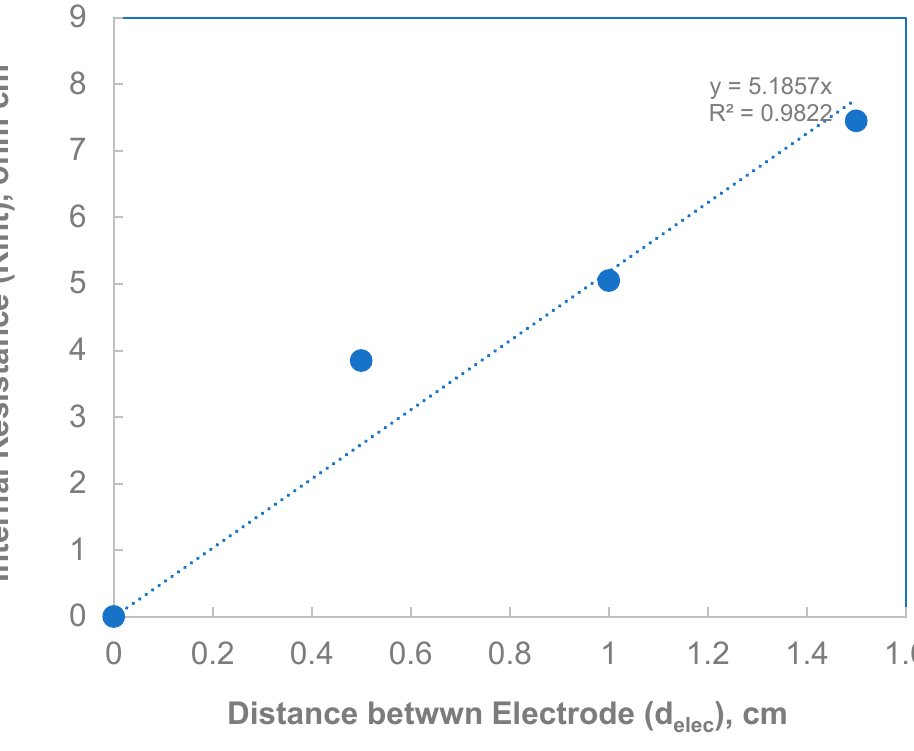
Figure 10. Plot of the anode–cathode distance against internal resistance Rint.